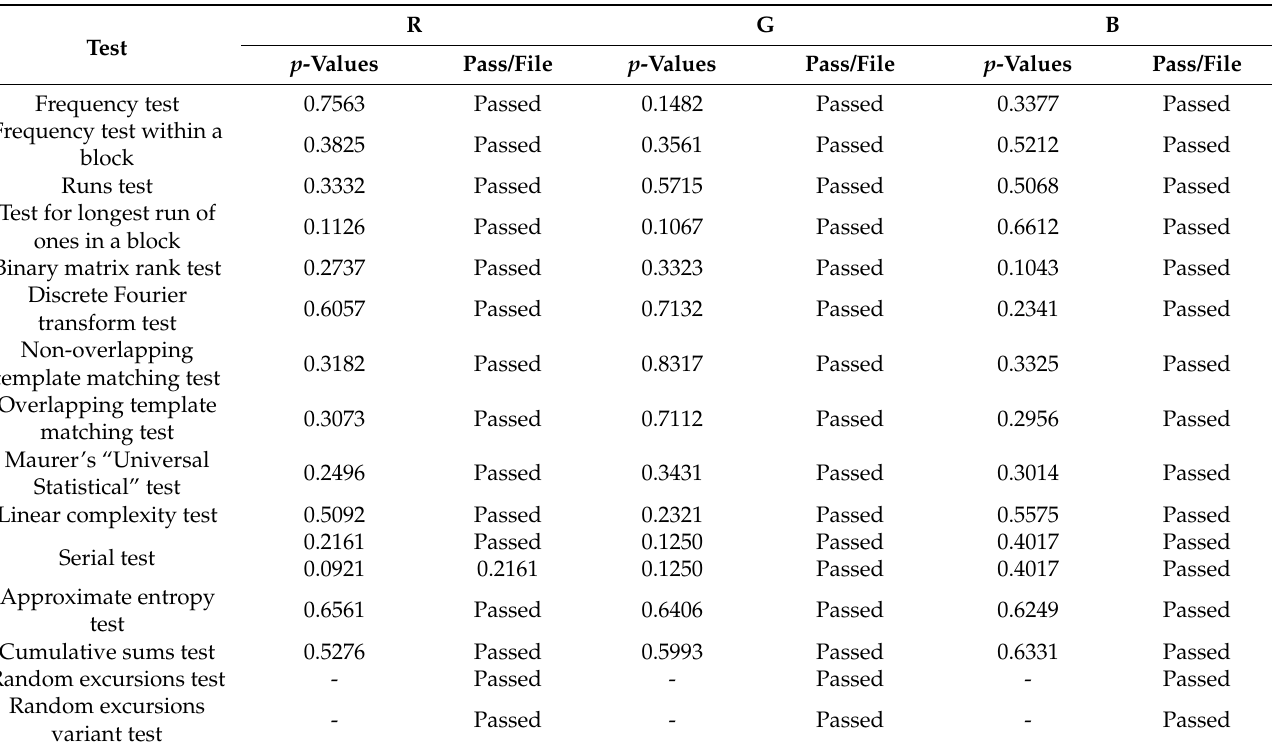
Table 14. NIST test results.